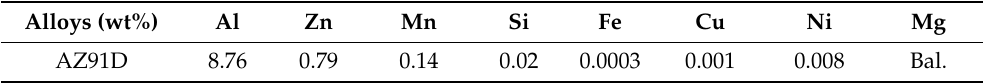
Table 1. Chemical composition of AZ91D magnesium